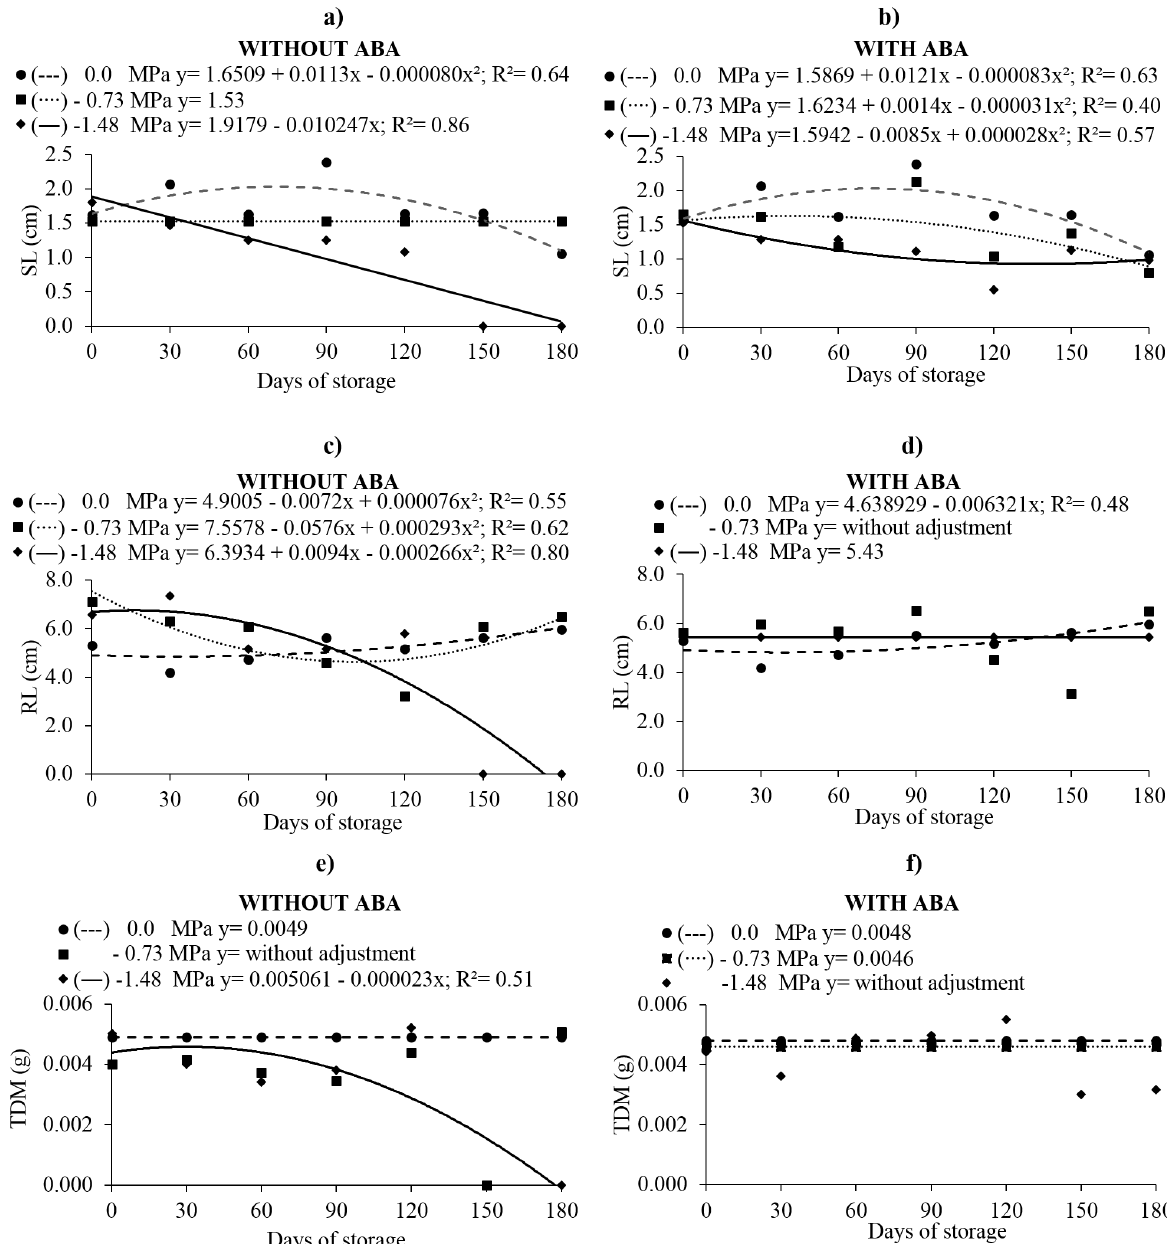
Figure 5 - Shoot length (SL - cm) ( a , b ), root length (RL - cm) ( c , d ) and total dry mass (TDM – g) ( e , f ) of A. edulis from seeds previously submitted to osmotic treatment with polyethylene glycol (PEG) in the potential of -0.73 and -1.48 MPa, associated or not with abscisic acid (ABA) and subsequently stored for different